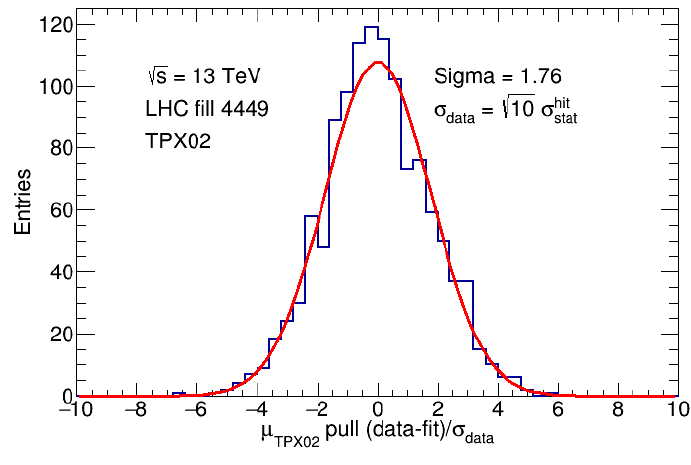
√ R · σ hit , with R = N hit / N cl = 10. stat